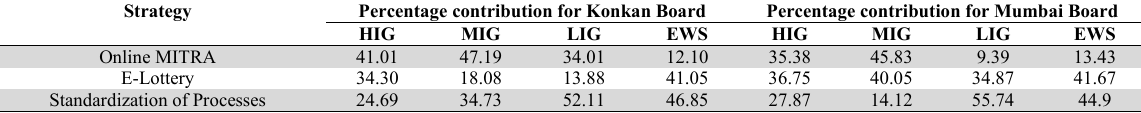
Percentage contribution of every strategy (Konkan and Mumbai Board) Strategy Percentage contribution for Konkan Board